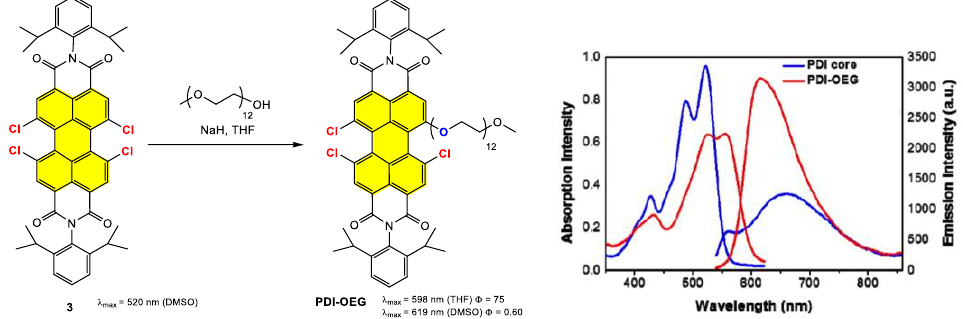
Figure 13. Synthesis of PDI-OEG; UV-Visible and fluorescence spectra of PDI 3 and PDI-OEG in PBS solution. Reprinted with permission from reference [118]. Copyright 2016 Optica Publishing Group.